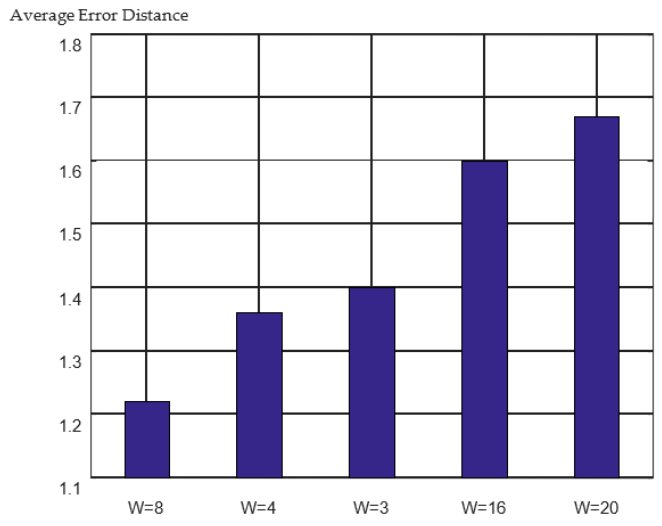
Figure 11. 3D positioning error of different series length.